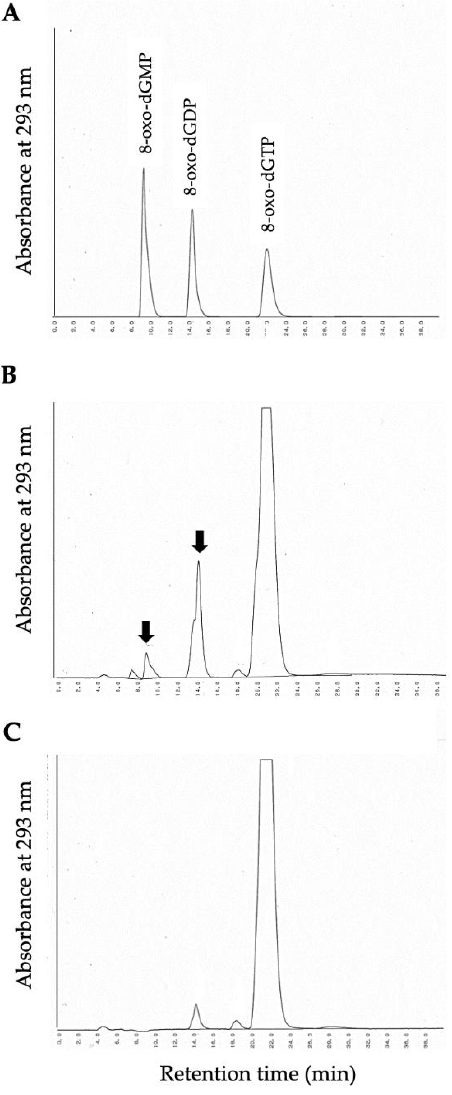
Figure 4. Identification of 8-oxo-dGTP degradation products by OsNUDX2. The reaction mixture containing 8-oxo-dGTP in the absence or presence of purified OsNUDX2 was incubated at 37 °C for 30 min and was subjected to HPLC. ( A ) Elution profiles of standard 8-oxo-dGTP, 8-oxo-dGDP, and 8-oxo-dGMP; ( B ) the elution profile of the reaction mixture with OsNUDX2; and ( C ) the elution profile of the reaction mixture without OsNUDX2.